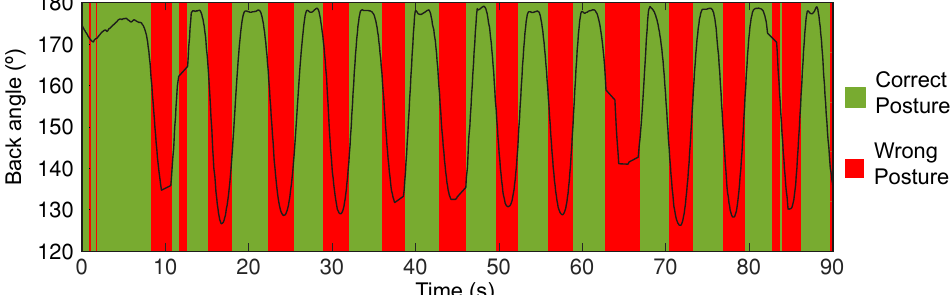
Figure 9. Posture classification using algorithm (green and red bars) and measured back angle (black